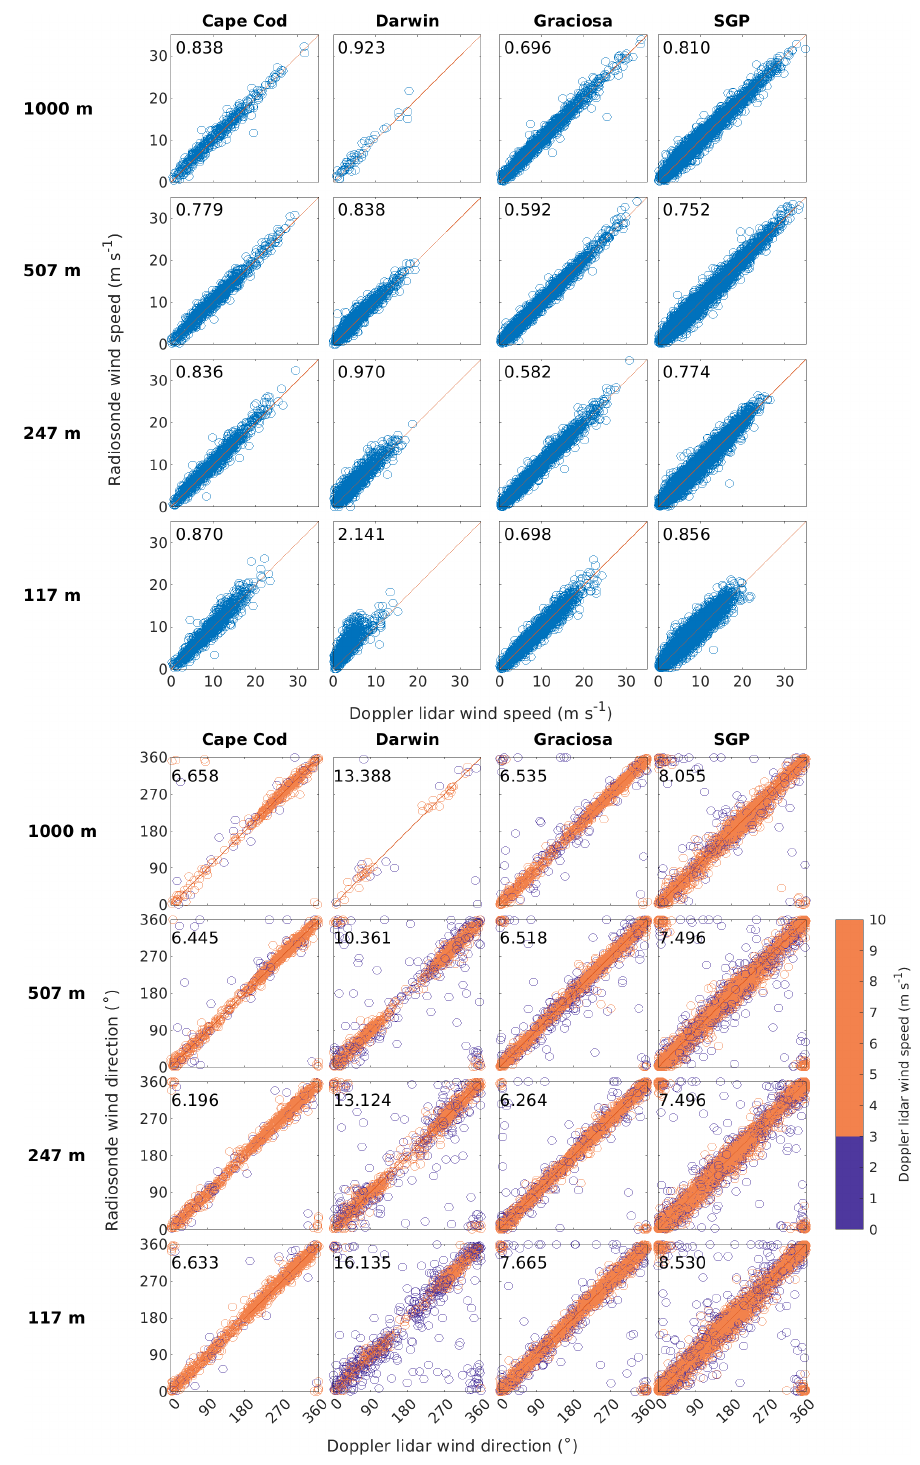
Figure 3. Scatter plots of Doppler lidar versus radiosonde wind speed and direction at four altitudes above ground level and at four locations. The mean absolute difference is also shown in each scatter plot. The wind direction is colour-coded in two classes with respect to the wind speed given by the Doppler lidar, denoting whether the wind speed was greater or less than 3ms − 1 .